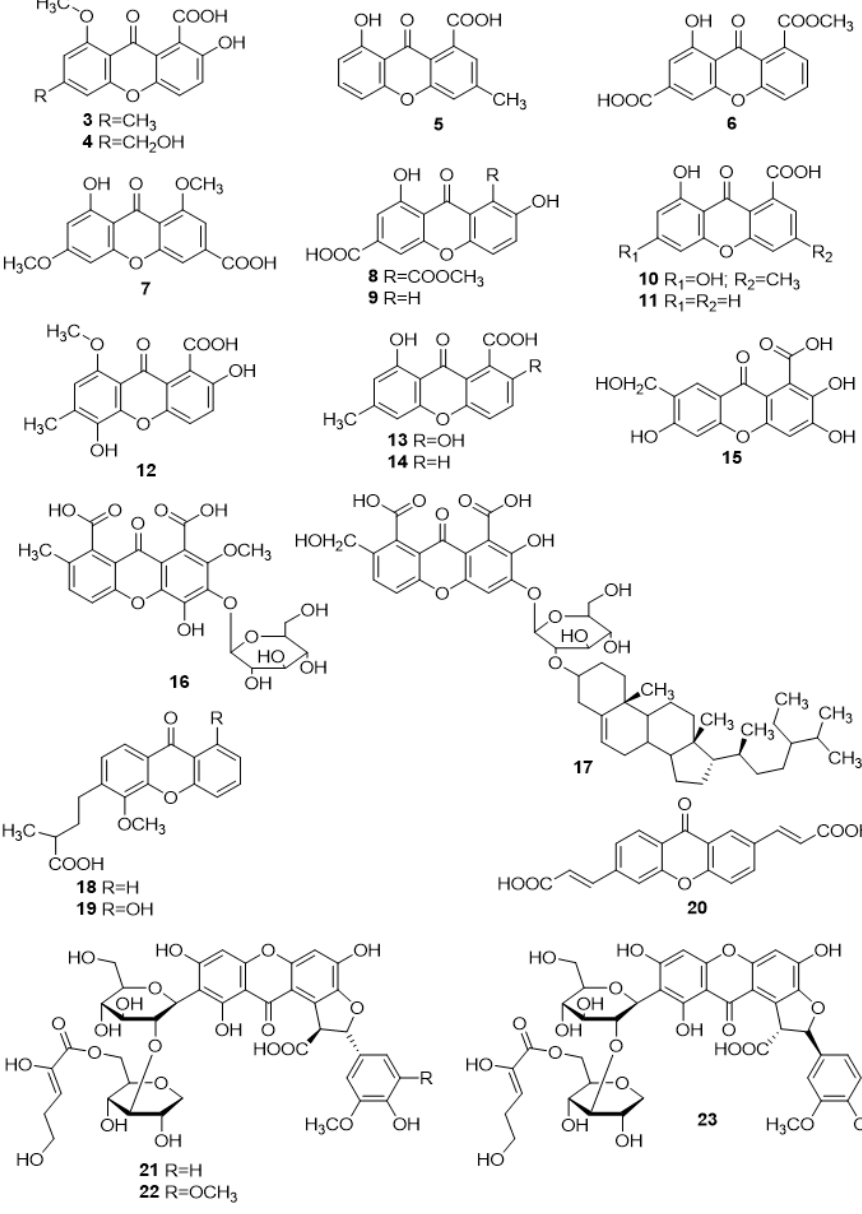
Figure 2. Structures of simple carboxyxanthone derivatives ( 3 – 23 ).